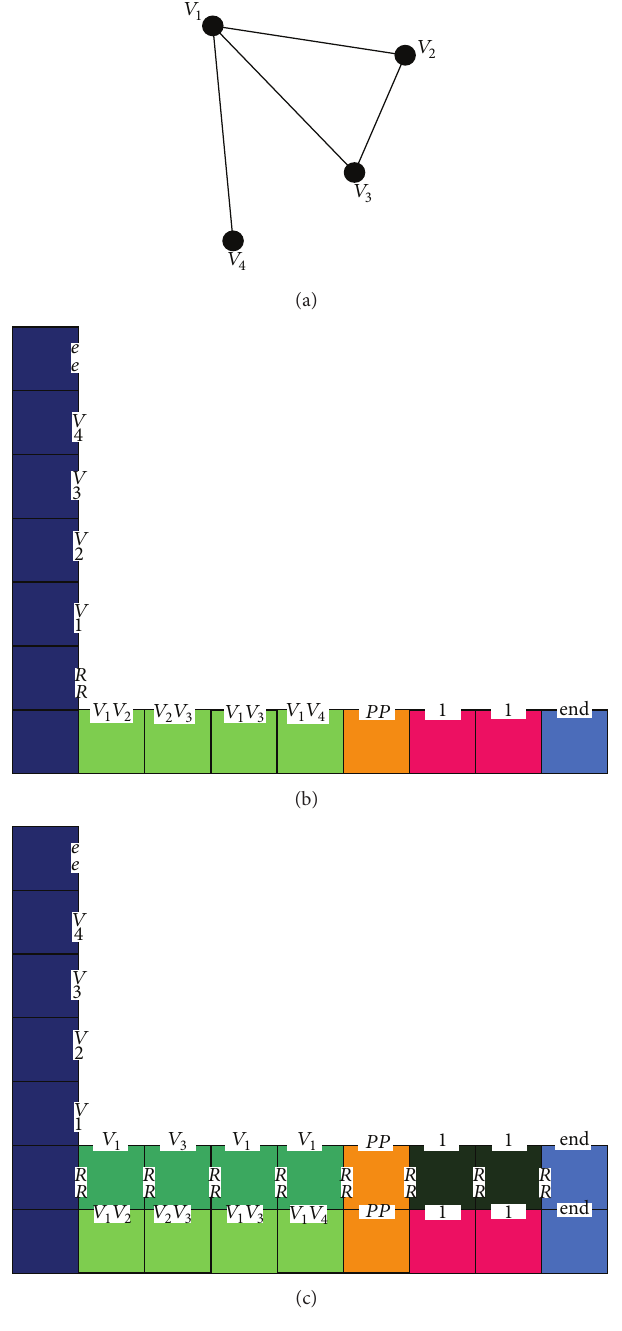
Figure 2: SYS V produces a final configuration 𝐹 on 𝑆 V such that 𝐹 produces one subset of vertices. (a) An example graph; (b) the example seed configuration; (c) in this example, 𝐹 constitutes one subset 𝑉 1 ,𝑉 3 ,𝑉 1 ,𝑉 1